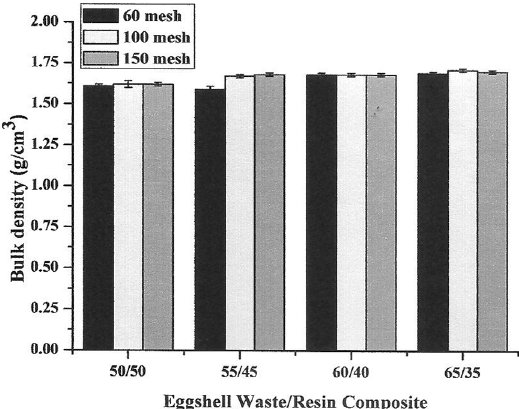
Figure 10. Bulk density the cured artificial rock